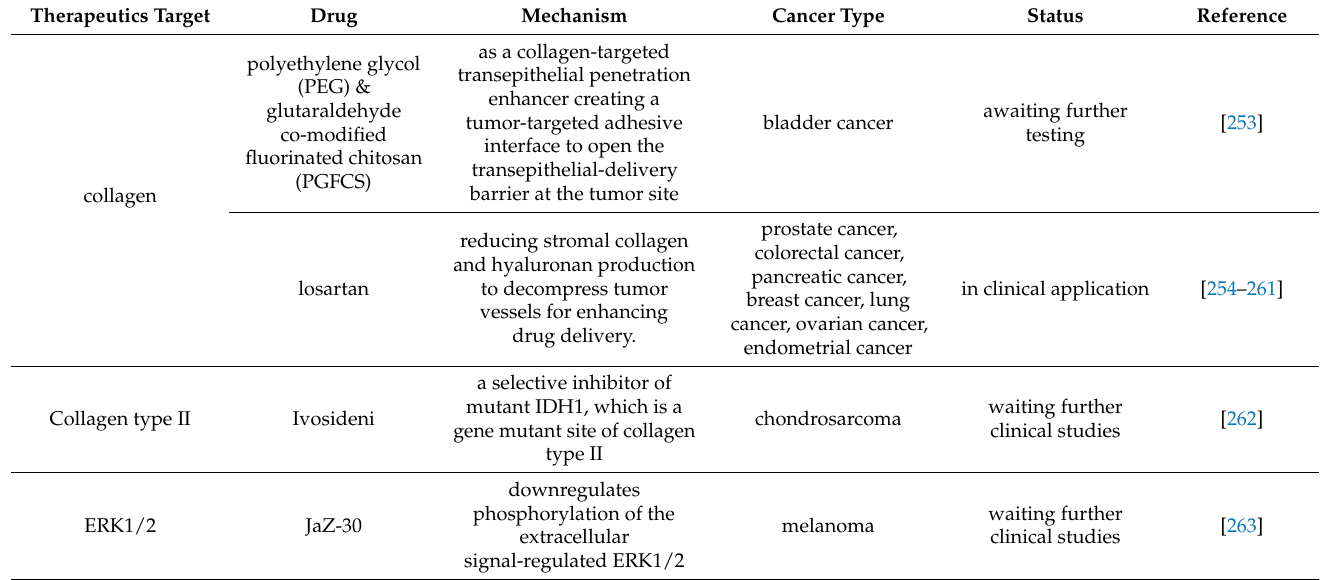
Table 5. The drugs that target collagen-induced